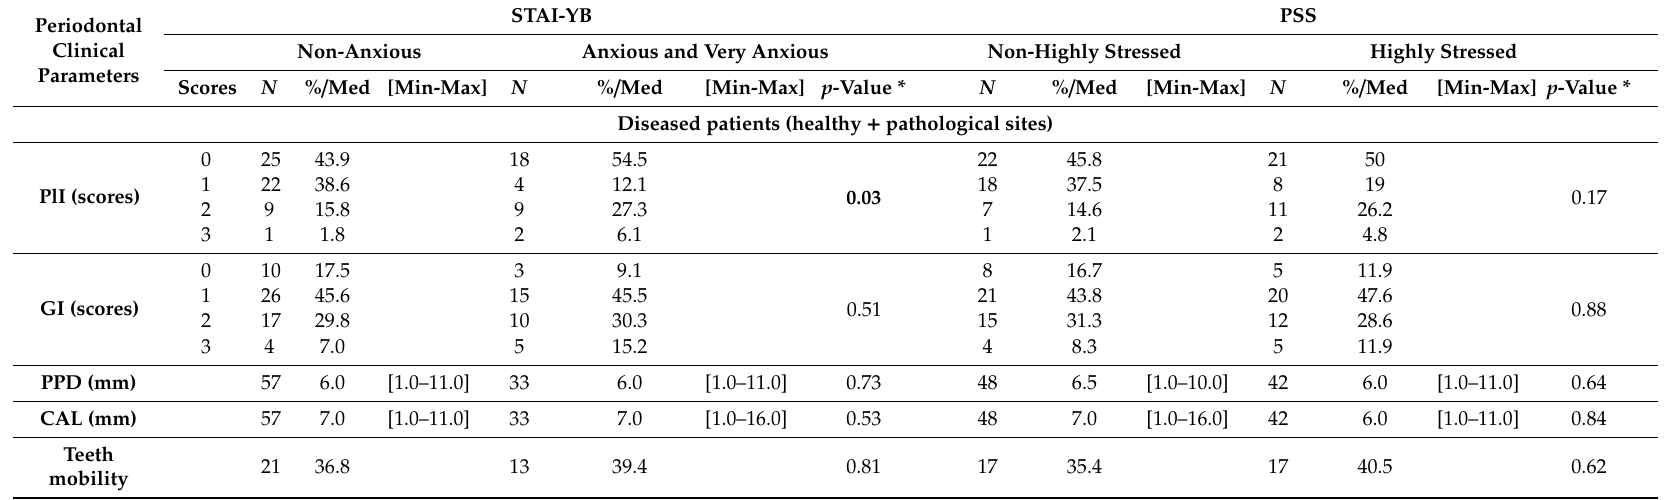
Table 2. Periodontal clinical parameters according to the psychosocial context of diseased patients.